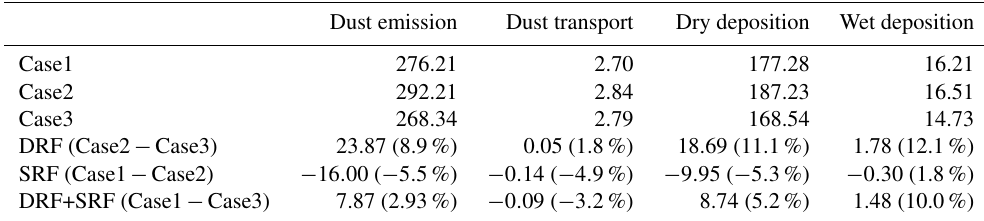
Figure 7. Spatial distribution of the changes in (a, c, e) the surface radiative forcing (Wm − 2 ) and (b, d, f) the surface temperature ( ◦ C) in MAM induced by dust direct radiative forcing (DRF), dust-in-snow radiative forcing (SRF) and total radiative forcing (DRF + SRF). The slanted lines represent the grid points where the changes pass the two-tailed t test at the 5% significance level. The green outlined area indicates the plateau above 2500m. Table 3. The March–April–May (MAM) averaged dust emissions (Tg per season), transport (gm − 1 s − 1 ), dry deposition (Tg per season), well as the corresponding differences between these three